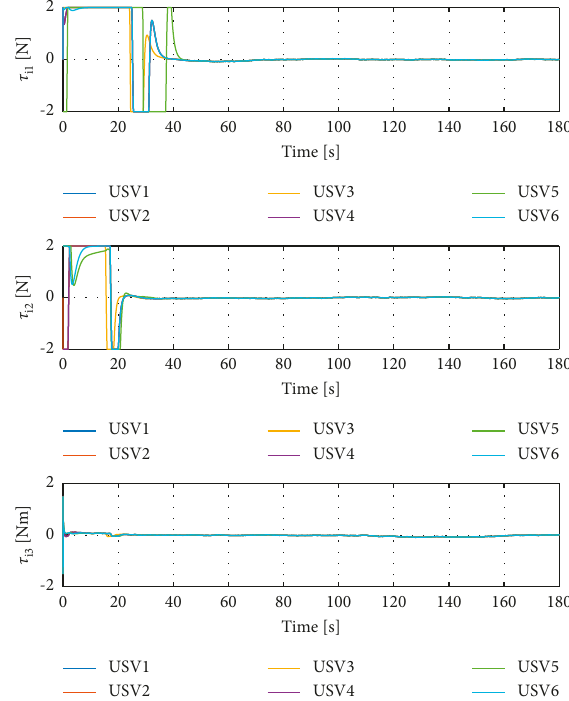
Figure 10: The control input ( τ saturation without ADS.